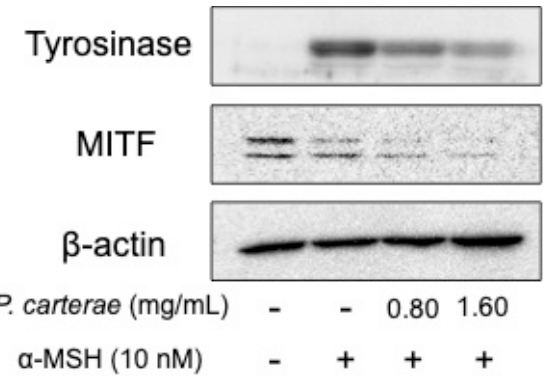
Figure 5. Western blot analysis of the effect of P. carterae extract on melanogenic protein expression. B16F1 melanoma cells were treated with P. carterae extract for 3 days. After treatment, western blotting of tyrosinase and microphthalmia-associated transcription factor (MITF) was performed. The loading control was assessed using anti- β -actin antibody.